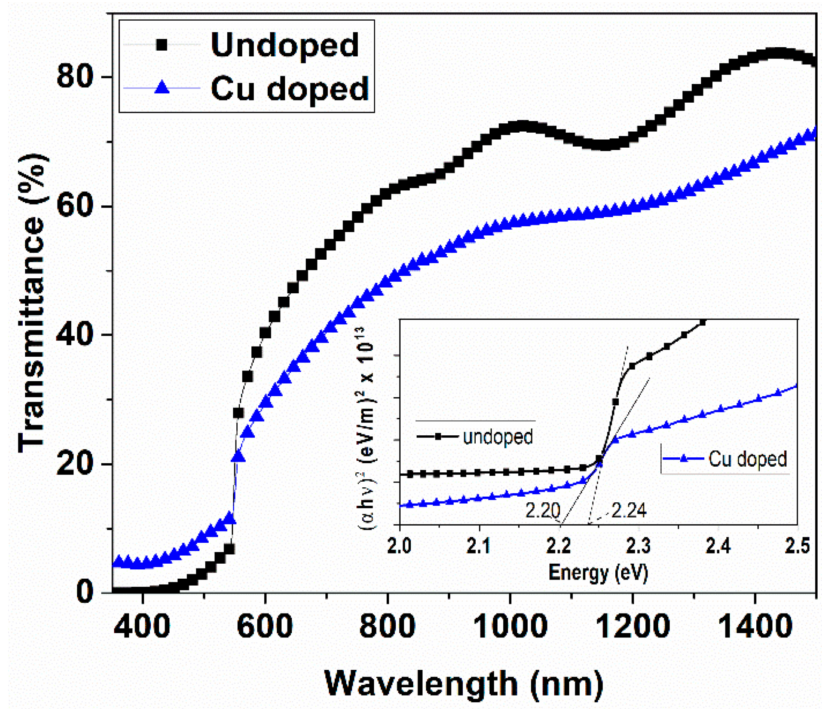
Figure 5. Transmission spectra of un-doped ZnTe thin films and Cu-doped ZnTe samples, the inset shows the calculation of bandgaps, using Tauc